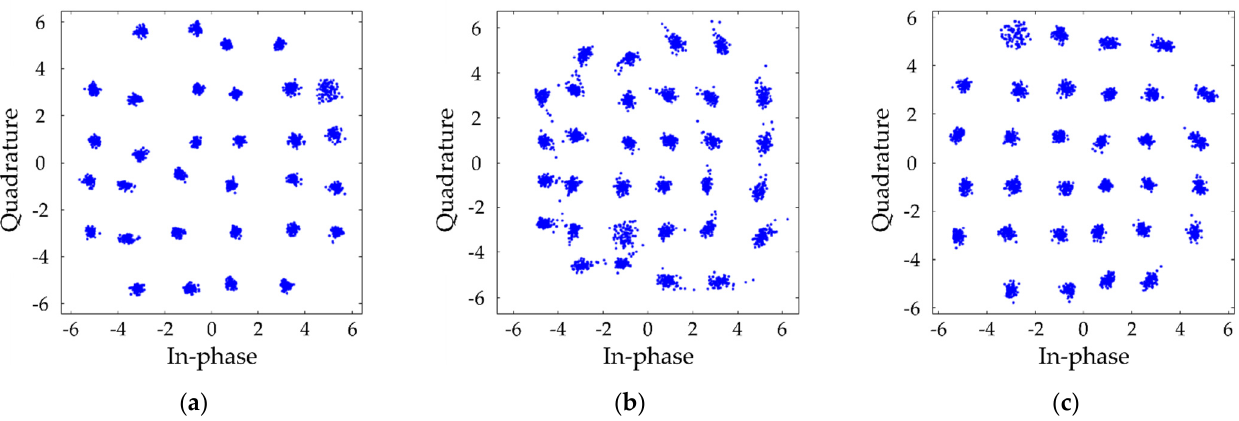
Figure 11. Constellation diagram of MIMO LED-to-LED system. ( a ) RtoR, ( b ) GtoG, and ( c ) BtoB when transfer data rate of each channel is 10.21 kbps. Table 2. BER comparison of the 3 × 3 MIMO LED-to-LED system at a transmission distance of 10 and 15 cm. BER Results at a Transmission Distance of